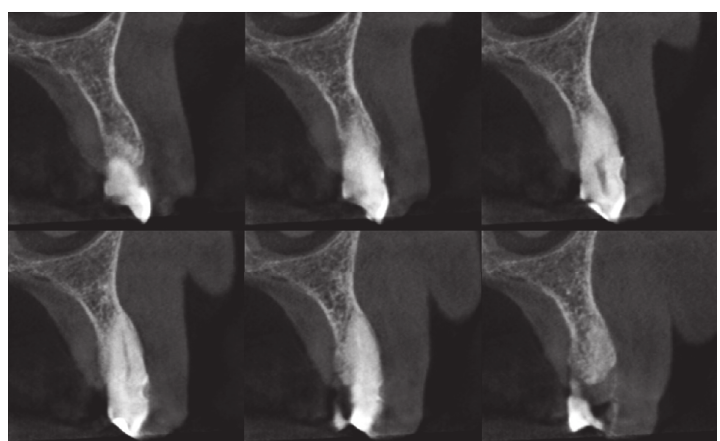
Figure 8: CT 10 months after biopsy.